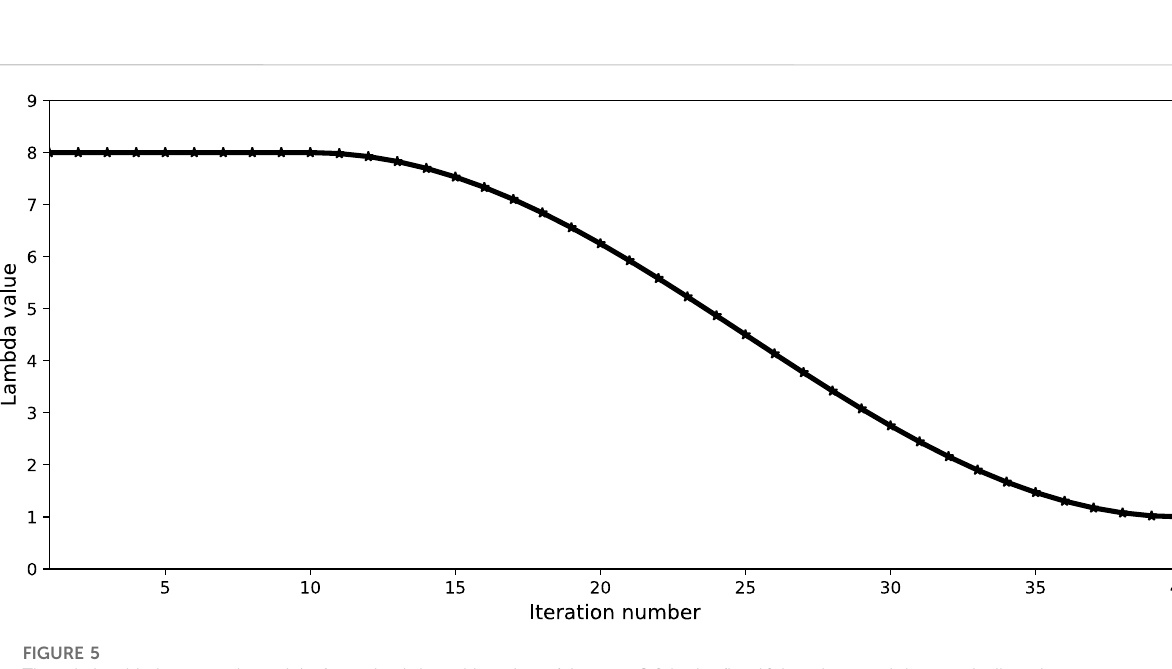
Frontiers in Earth